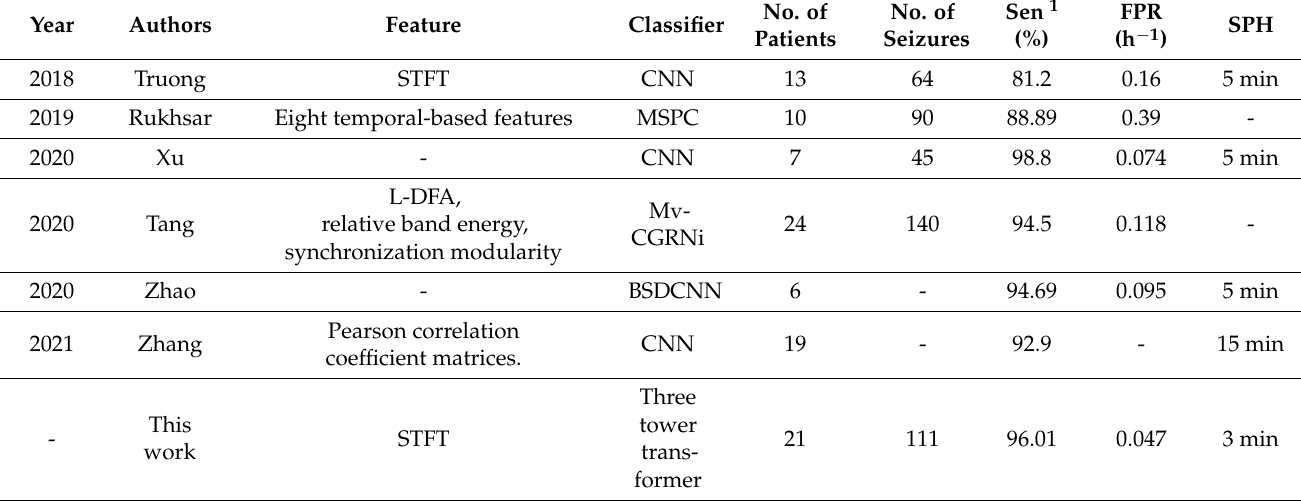
Table 5. The comparison of the results of this work with other reported